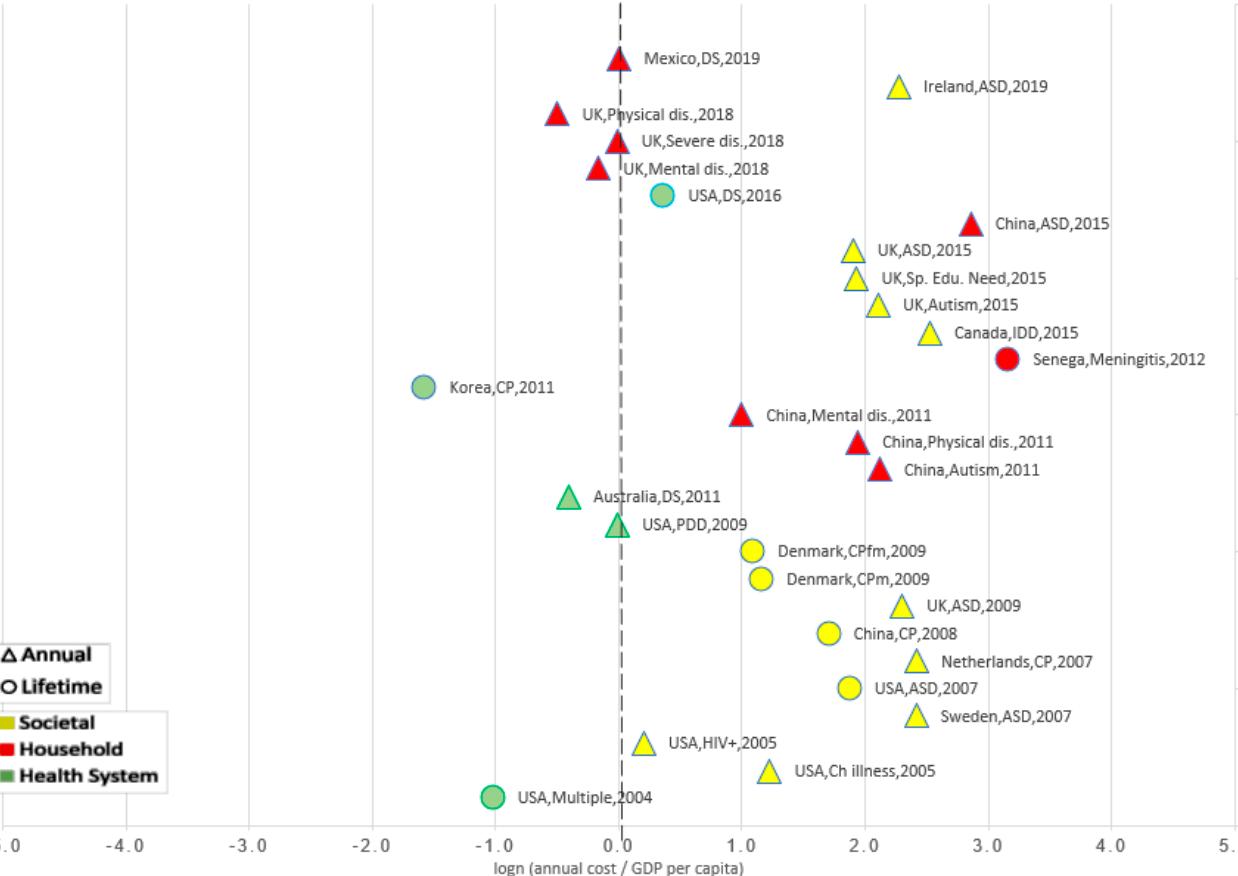
Figure 3. Annual childhood disability costs compared with CHE per capita. Care must be taken not to simply compare the costs from different studies as there are considerable methodological differences between them, this graph is just a way of summarizing these differences.